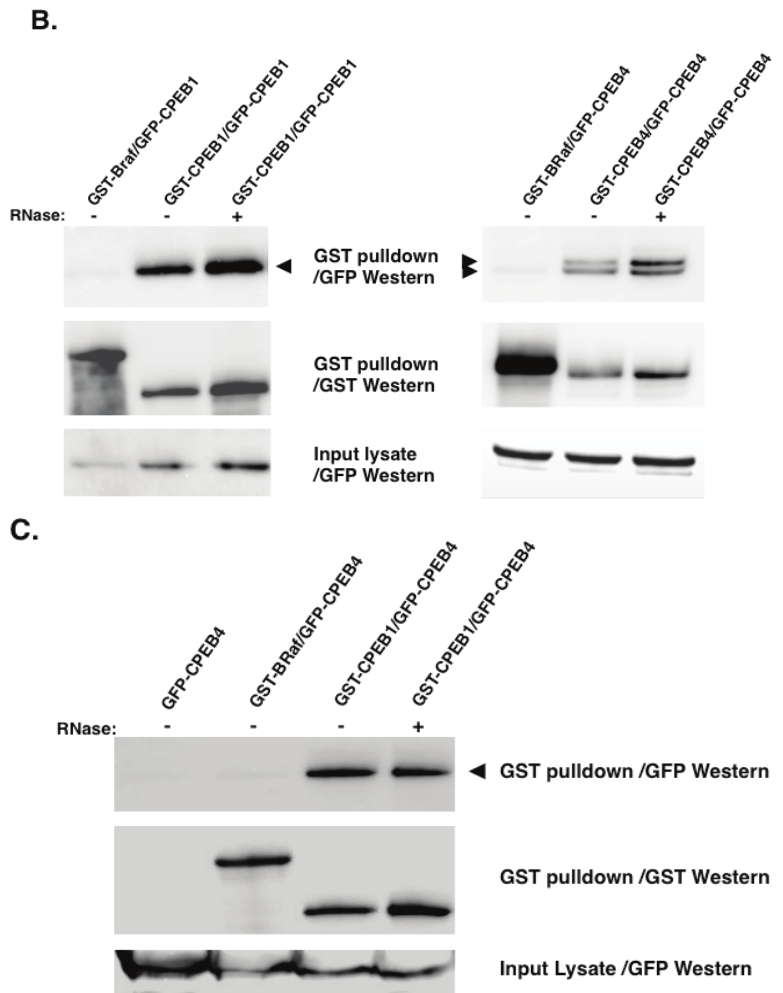
Figure 3. Musashi co-association with other RBPs is RNA-independent ( A ) Forty oocytes were co-injected with mRNA encoding GFP-Musashi1 (Msi) and either GST-BRaf, GST-Msi, GST-CPEB1 or GST-CPEB4. The GFP tagged mammalian Musashi1 protein construct [75], and GST-tagged human CPEB1 [91] have been described previously. The CPEB4 protein construct was generated by a PCR mediated subclone of KIAA 1673 (Origene Technologies, Inc., Rockville, MD USA) into the pXen2 vector [92]. In vitro transcribed RNA was prepared for each construct and injected into immature oocytes. The injected oocytes were incubated overnight to express the introduced proteins then lysed. Lysates were then subjected to GST-pulldown and treatment with RNase1 as described [75]. Associations were visualized by western blotting. GST-XMsi1, GST-CPEB1 and GST-CPEB4 associate with GFP-Msi in an RNase1 independent manner, while the GST-BRaf does not (upper panel, arrowhead); ( B ) Oocytes were injected with the indicated mRNA combinations and CPEB1 (left panel) or CPEB4 (right panel) oligomerization assessed by GFP western blotting (arrowhead, upper panels) in the presence or absence of added Rnase1, essentially as described in panel ( a ) above. No co-association was seen with BRaf. The expressed CPEB4 protein runs as a doublet in these experiments; ( C ) Oocytes were injected with the indicated mRNA combinations and CPEB1:CPEB4 co-association assessed by GFP western blotting, as described in panels ( A , B